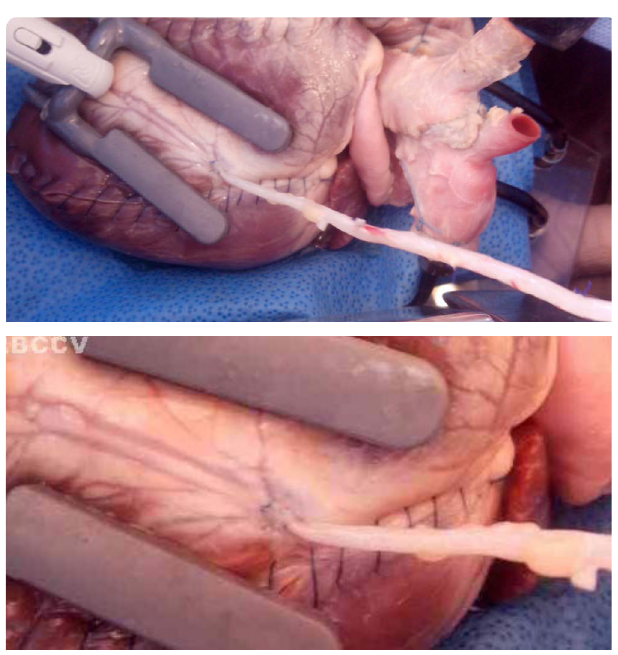
Fig. 10 - Saphenous vein-coronary artery anastomosis in pig heart using the simulation model with dummy with porcine beating